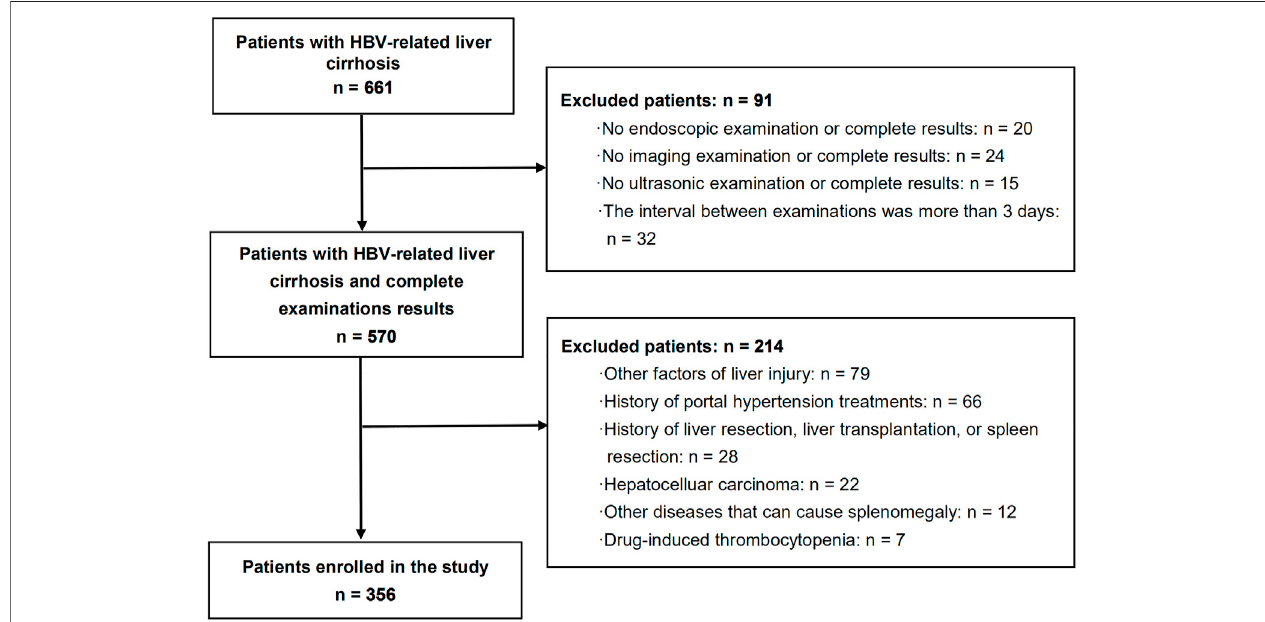
FIGURE 1 | Flowchart of the studied